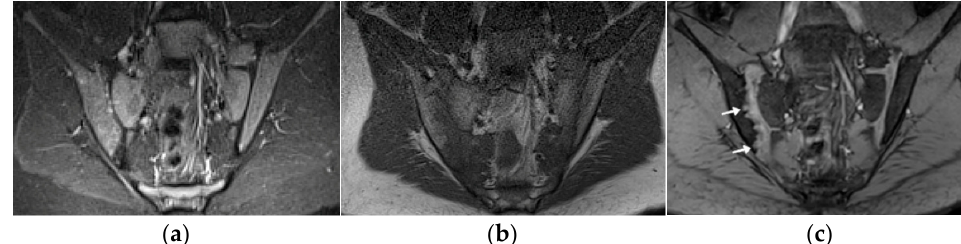
Figure 8. Follow-up MRI of the sacroiliac joints (only anterior superior part is shown) in a 14-year-old boy with juvenile spondyloarthritis (SpA), coronal short tau inversion recovery (STIR) ( a ), T1 TSE ( b ), and volume-interpolated breath-hold examination (VIBE) ( c ): joints without active lesions ( a ), with numerous erosions in the right joint that are difficult to depict on the T1, and are better visualized on the VIBE sequence (arrows).